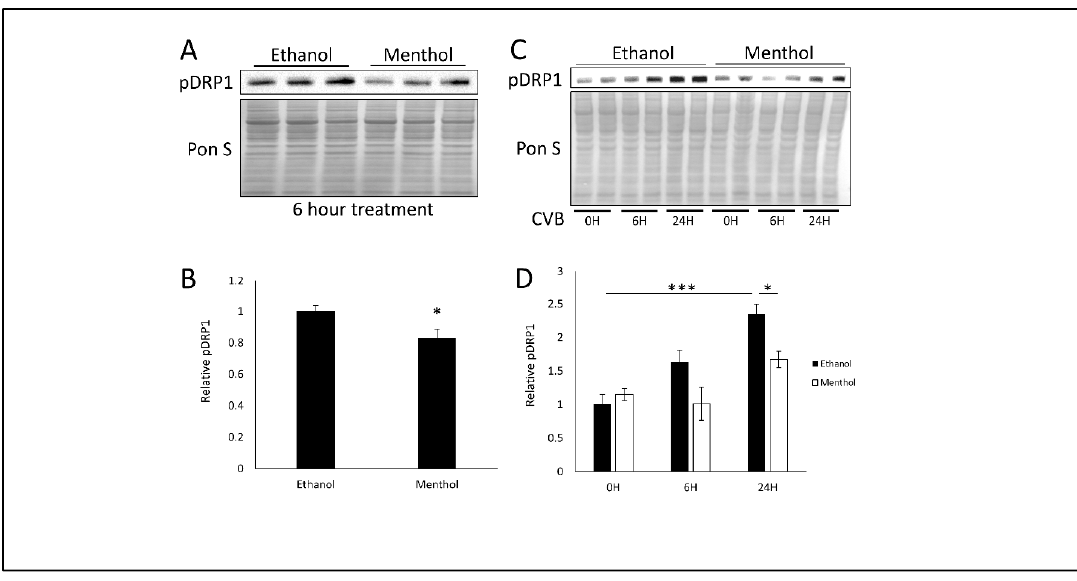
Figure 5. Menthol treatment reduces mitochondrial fission basally and during CVB infection- HeLa cells were treated with 1 mM menthol and then examined after 6 h. ( A ) Western blot on cell lysates detecting mitochondrial fission marker phospho-DRP1Ser616 (pDRP1). Ponceau S is shown below. ( B ) Densitometric quantification of western blot in A. HeLa cells were treated with 1 mM menthol or equivalent dose of ethanol for 1 h and subsequently infected with EGFP-CVB at MOI 0.1 for 24 h. ( C ) Western blot on cell lysates detecting pDRP1. Ponceau S is shown below. ( D ) Densitometric quantification of western blot in C. (* p < 0.05, *** p < 0.001; Student’s t-test, n = 3–4).